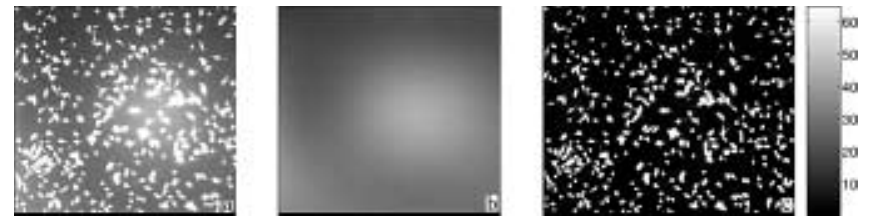
Fig. 2. Original image before background correction (a), the fitted spline surface of the background (b) and the image after background subtrac- tion (c). Note that the intensity scale (same for all images) has been set to enhance the contrast of the darker parts of the images.